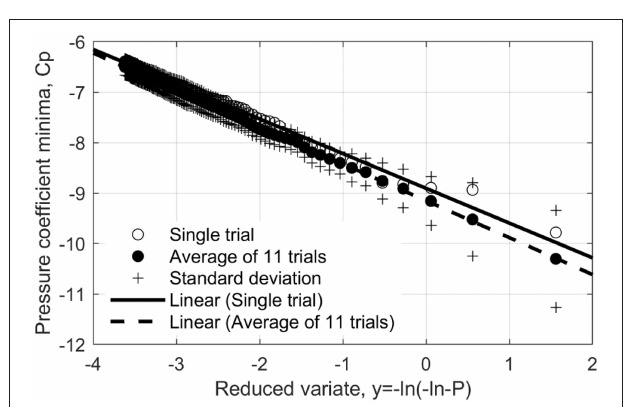
FIGURE 4 | Gumbel plot from XIMIS method, T = 160min, for Tap A.